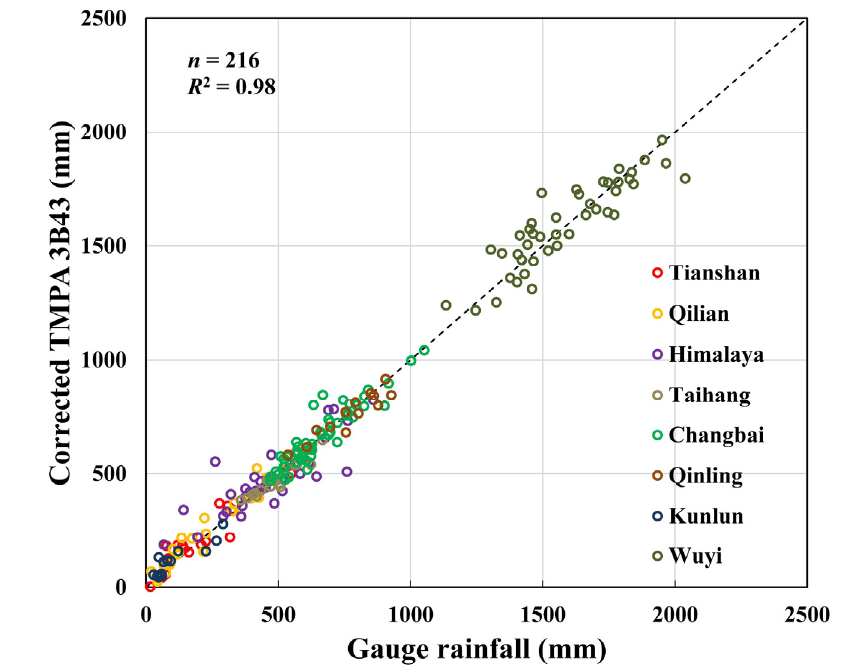
Figure 5. Cross-Validation of the Location-Elevation-TMPA (LET) method using mean annual rainfall (2001–2012) from gauge measurements and corrected 3B43. Table 4. Comparison of mean annual rainfall (2001–2012) from gauges and corrected 3B43.